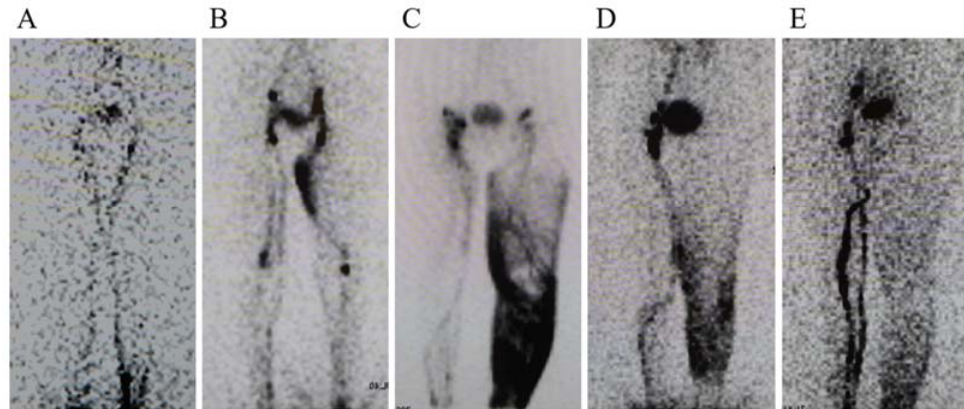
Figure 2. Lymphoscintigraphy images of stages I to V. ( A ) Stage 1: The number of visible inguinal lymph nodes is reduced. ( B ) Stage 2: Few or no inguinal lymph nodes were observed. Dermal backflow was observed in the thigh. ( C ) No inguinal lymph nodes were detected, and dermal backflow was observed in the thigh and/or leg. ( D ) Recognition of dermal backflow and lymph stasis in the lymphatic system of the leg. ( E ) No dermal backflow in the thigh or leg was observed.